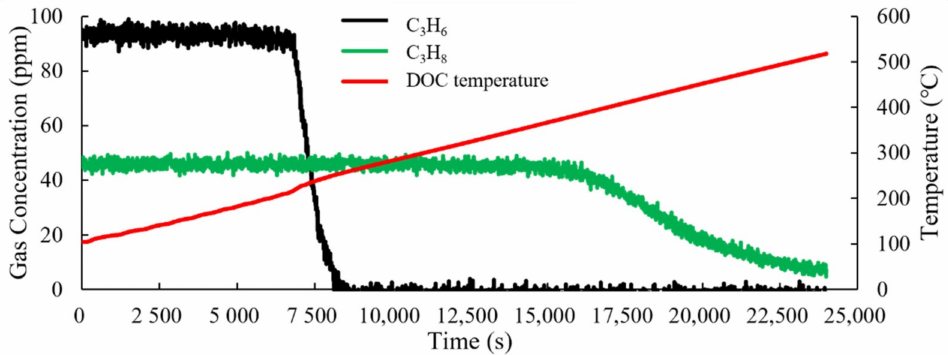
Figure 3. Change in the hydrocarbon concentration in test